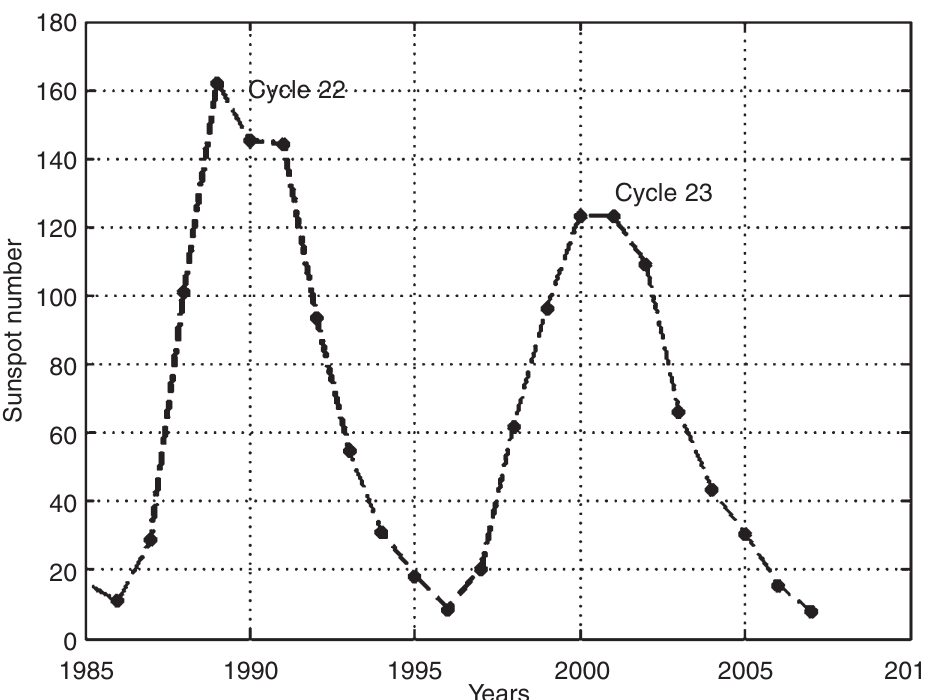
Fig. 4. Yearly average Sunspot number in the time interval